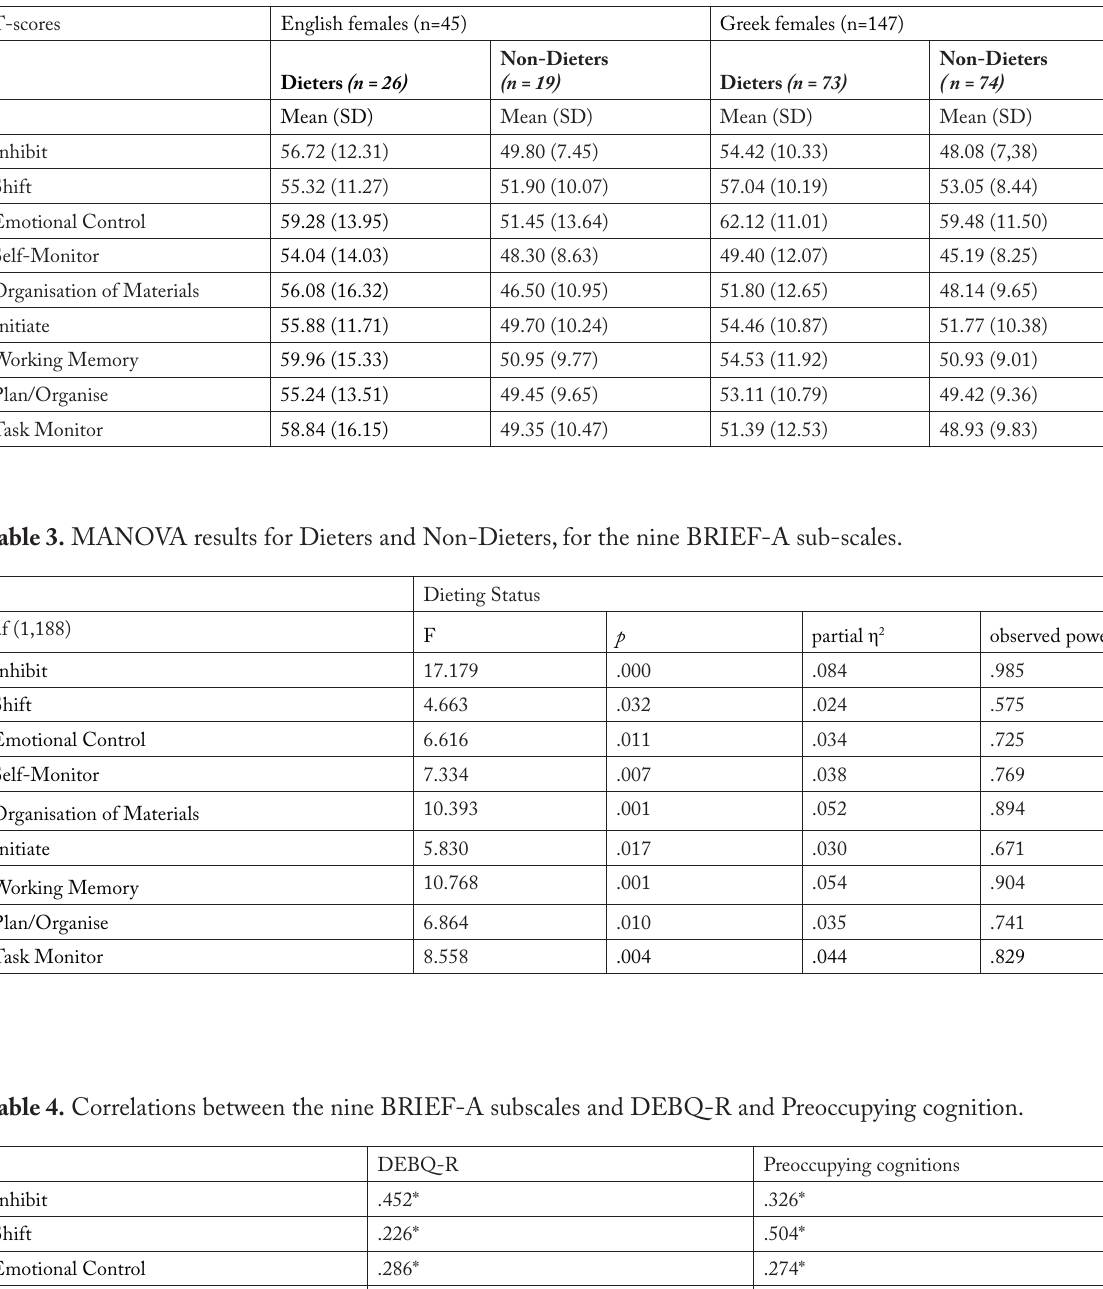
Table 2. Mean T-Scores for the nine BRIEF-A sub-scales for female English and Greek, Dieters and Non-Dieters.